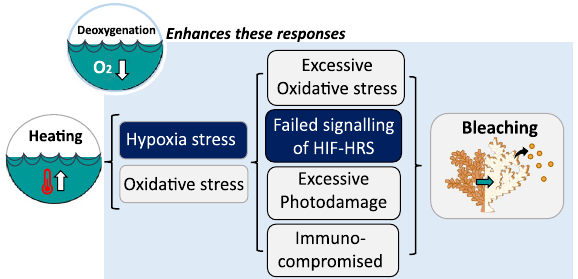
Figure 4. Incorporating hypoxia stress into the coral bleaching response. ROS accumulation is commonly observed in heat stressed corals, although it is unclear whether it is the actual trigger or a ‘smoking gun’, i.e. downstream of further upstream events that initiate the symbiotic breakdown 22,97 . Despite such uncertainties, hypoxia stress during heating may play a pivotal role in determining coral bleaching susceptibility. Specifically, hypoxia- and heat-driven excessive oxidative stress could hamper signalling of the Hypoxia-inducible Factor (HIF) hypoxia response system (HRS), enhance photodamage, and leave the coral immune-compromised. Increasing deoxygenation may thus increase coral bleaching